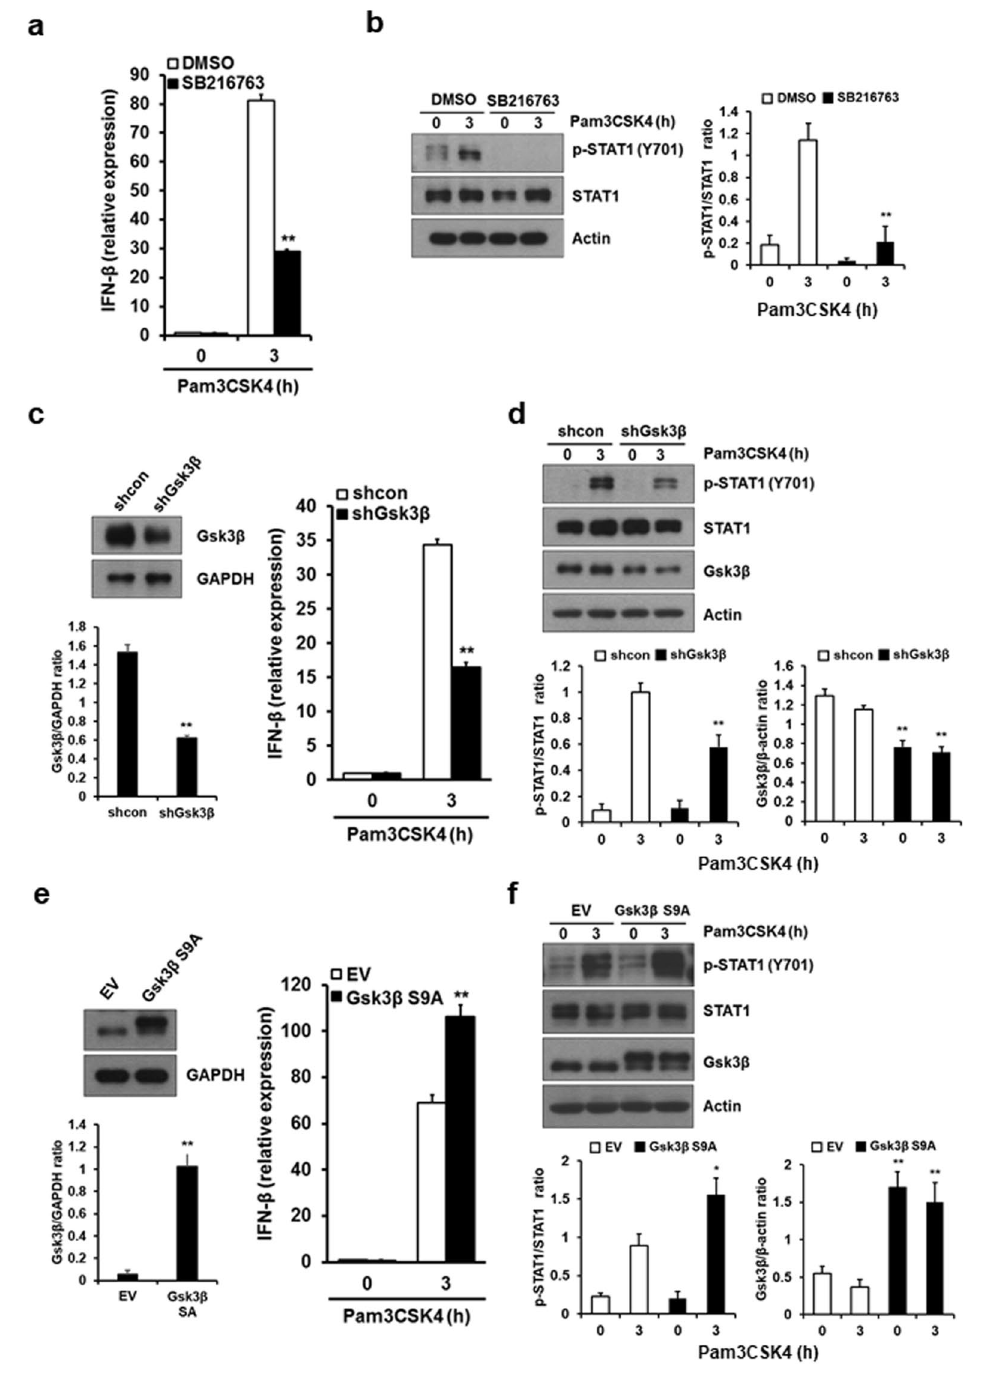
Figure 2. Gsk3 β is involved in IFN- β induction upon TLR2 stimulation. ( a , b ) BMDMs were pretreated with 5 μ M Gsk3 β inhibitor, SB216763, for 30 min and stimulated with 1 μ g/ml Pam3CSK4 for the indicated times. IFN- β mRNA levels were measured by real-time PCR ( a ). STAT1 phosphorylation and expression levels of STAT1 were determined by Western blotting ( b ). ( c , d ) BMDMS were infected with a retrovirus expressing control shRNA (shcon) or Gsk3 β -specific shRNA (shGsk3 β ) as in Fig. 1c. Expression of IFN- β mRNA was measured as in ( c ). STAT1 phosphorylation and expression levels and Gsk3 β protein levels were determined as in ( d ). ( e , f ) BMDMs were infected with a retrovirus expressing pMX-Puro (EV) or constitutively active Gsk3 β (Gsk3 β S9A). The experiment was performed as described in ( c , d ). Representative Western blots and quantification (shown in the bar graph) of indicated proteins/control ratio in the lysates of cells are shown in ( b , c , d , e , f ). Data represent the means of triplicate samples ± SD and are representative of at least three experiments. Statistical analyses were carried out using Student’s t -test ( * P < 0.05, ** P < 0.01). The uncropped images are in Supplementary Fig.